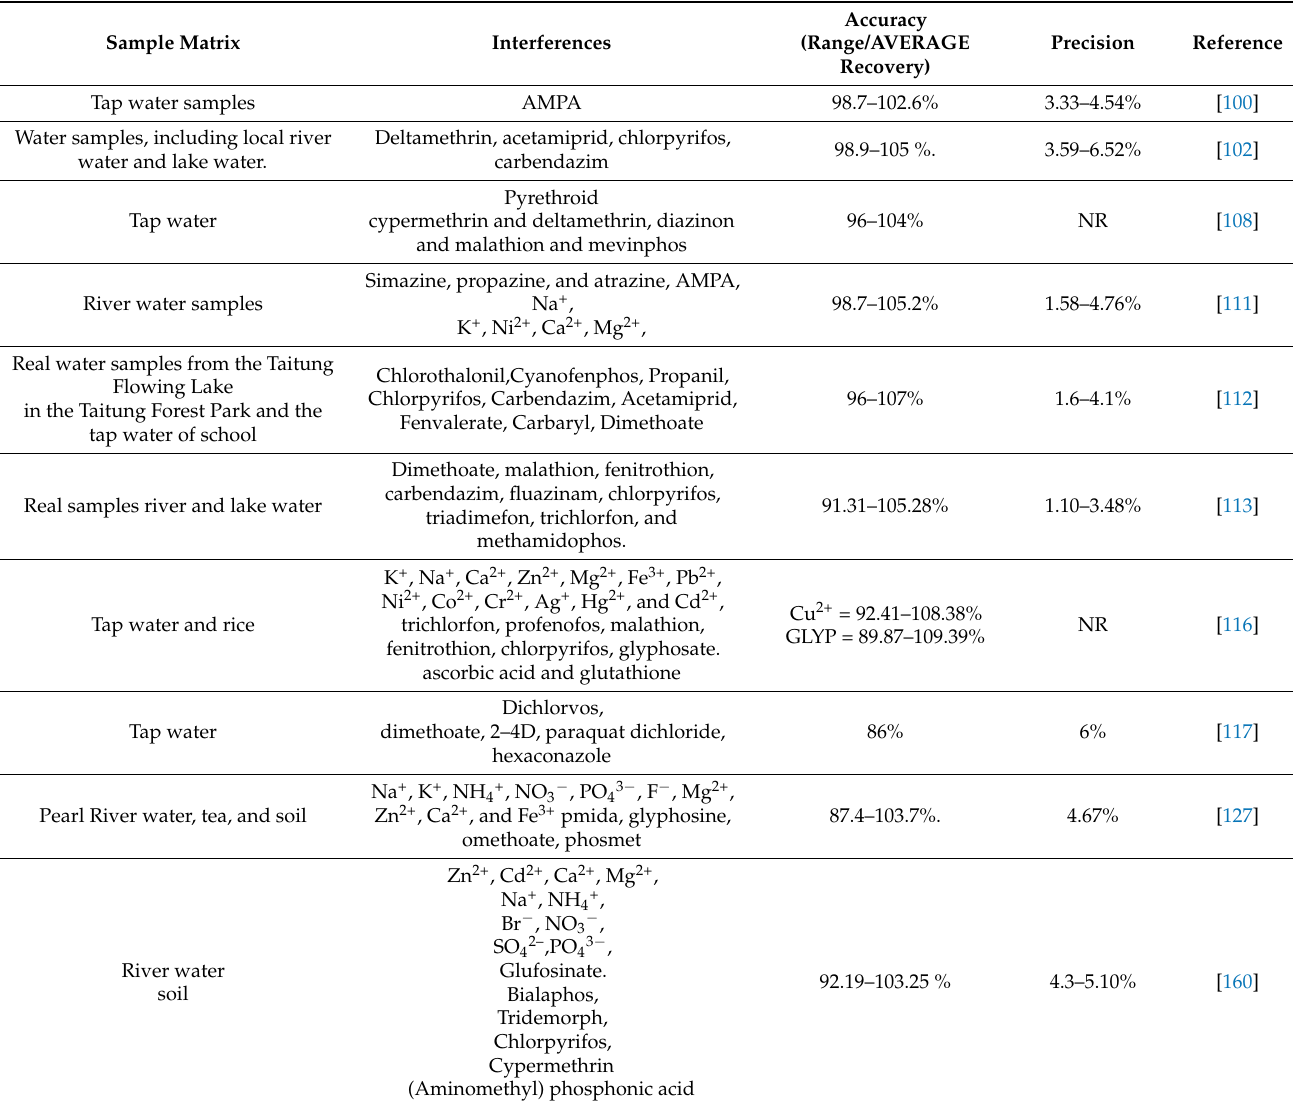
Table 5. Accuracy and precision of nanosensors for GLYP determination in environmental water